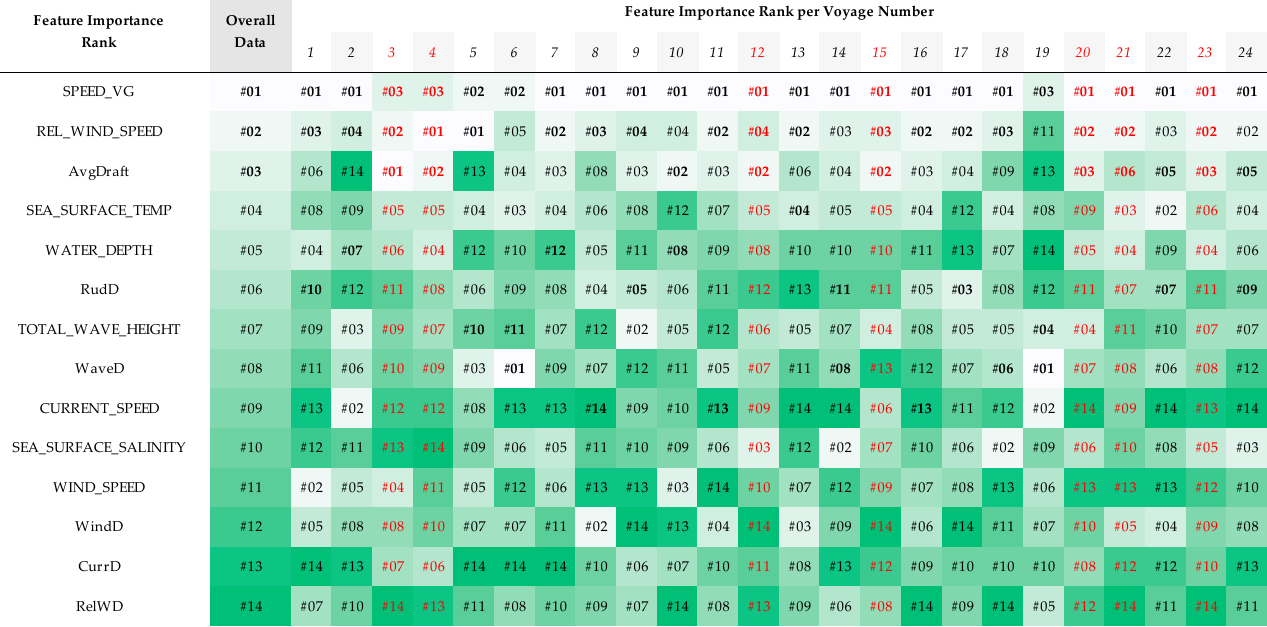
Figure 13. SHAP feature importance ranking heatmap.